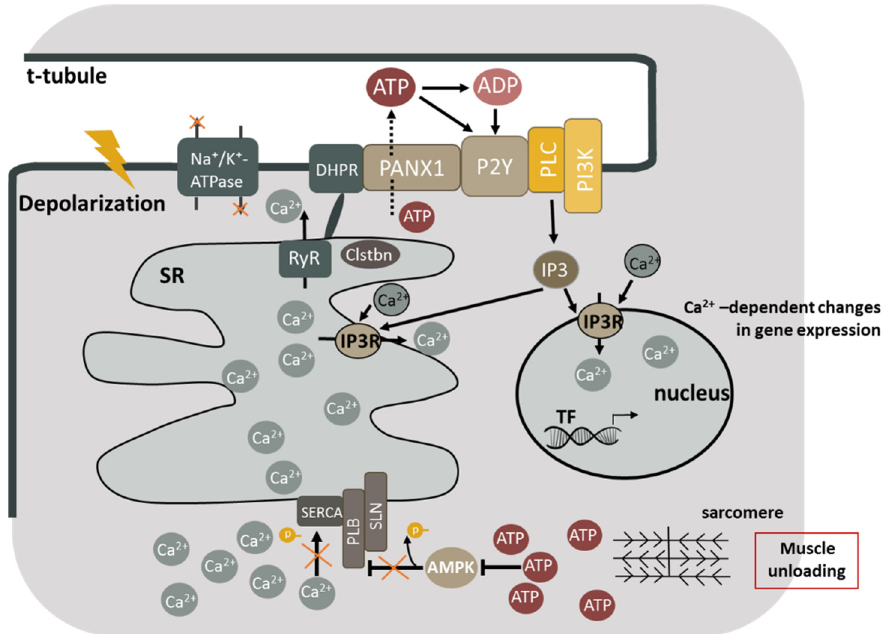
Figure 1. Molecular mechanisms contributing to the sarcoplasmic calcium accumulation during skeletal muscle unloading. Inactivation of Na,K-ATPase leads to sarcolemma depolarization, which in turn causes the activation of DHPR and the opening of RyR. Sarcoplasmic calcium accumulation leads to the detachment of calstabin from the ryanodine receptor and the occurrence of calcium leakage. Meanwhile, the inactivation of AMP-dependent protein kinase leads to dephosphorylation of PLN, and the blockage of SERCA. Excessive accumulation of calcium ions in the sarcoplasm causes calcium-dependent proteolysis and changes in gene expression in muscle fibers. ATP is released by PANX1 under functional muscle unloading. ATP is rapidly degraded to ADP, AMP, and adenosine under the action of ectonucleotidases. ATP and ADP can affect P2Y receptors as- sociated with G proteins that in turn activate PI3 kinase. PI3 kinase catalyzes phosphorylation of phosphatidylinositol diphosphate (PIP2), giving PIP3 a highly charged residue, which recruits phospholipase C into the membrane, triggering the formation of inositol-1,4,5-triphosphate (IP3). IP3 then binds to IP3 receptors (IP3R) present both in the nuclear envelope and in the sarcoplas- mic network, causing a weak signal of calcium release both in the cytosol and in the nucleoplasm, which contributes (probably, with other signaling cascades) to the activation of transcription fac- tors (TF) leading to the expression or repression of the genes involved in the phenotype of muscle cells. DHPR—dihydropyridine channels; RyR—ryanodine receptors; SERCA—sarcoplasmic